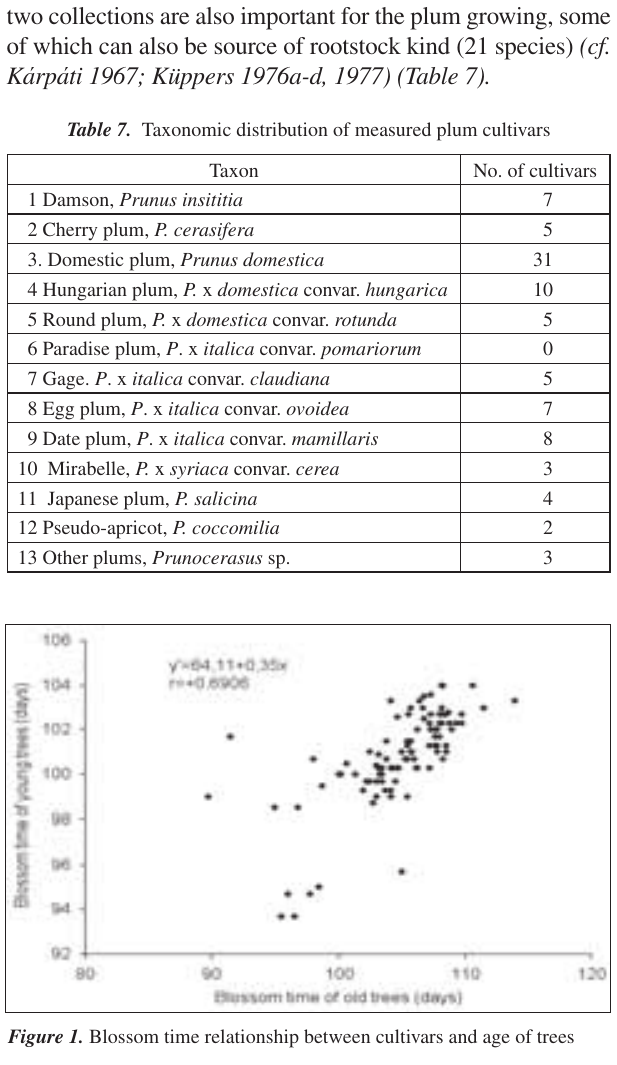
Table 6. Stability of connection according age of trees Relationship